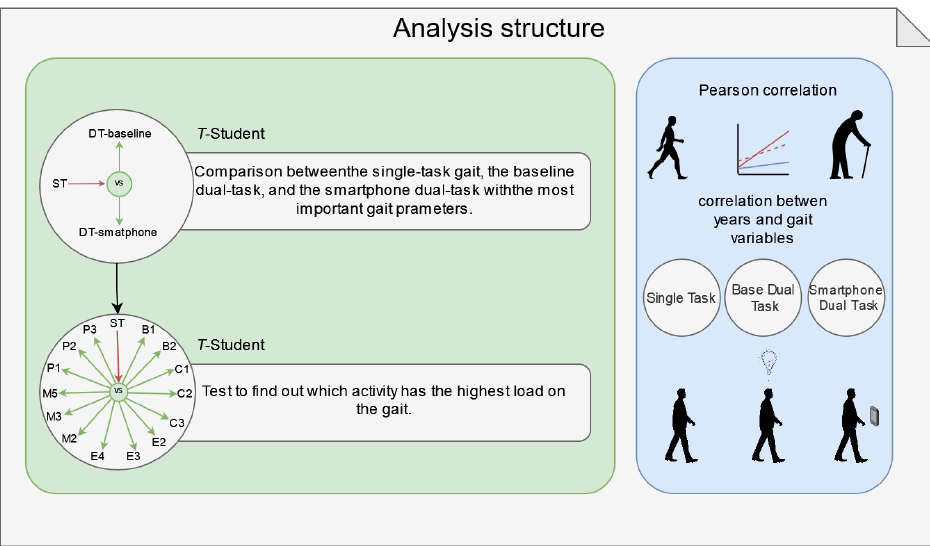
Figure 3. Structure of the analysis carried out in this paper (the included graphs are just for illustration, results are explained in section 3).